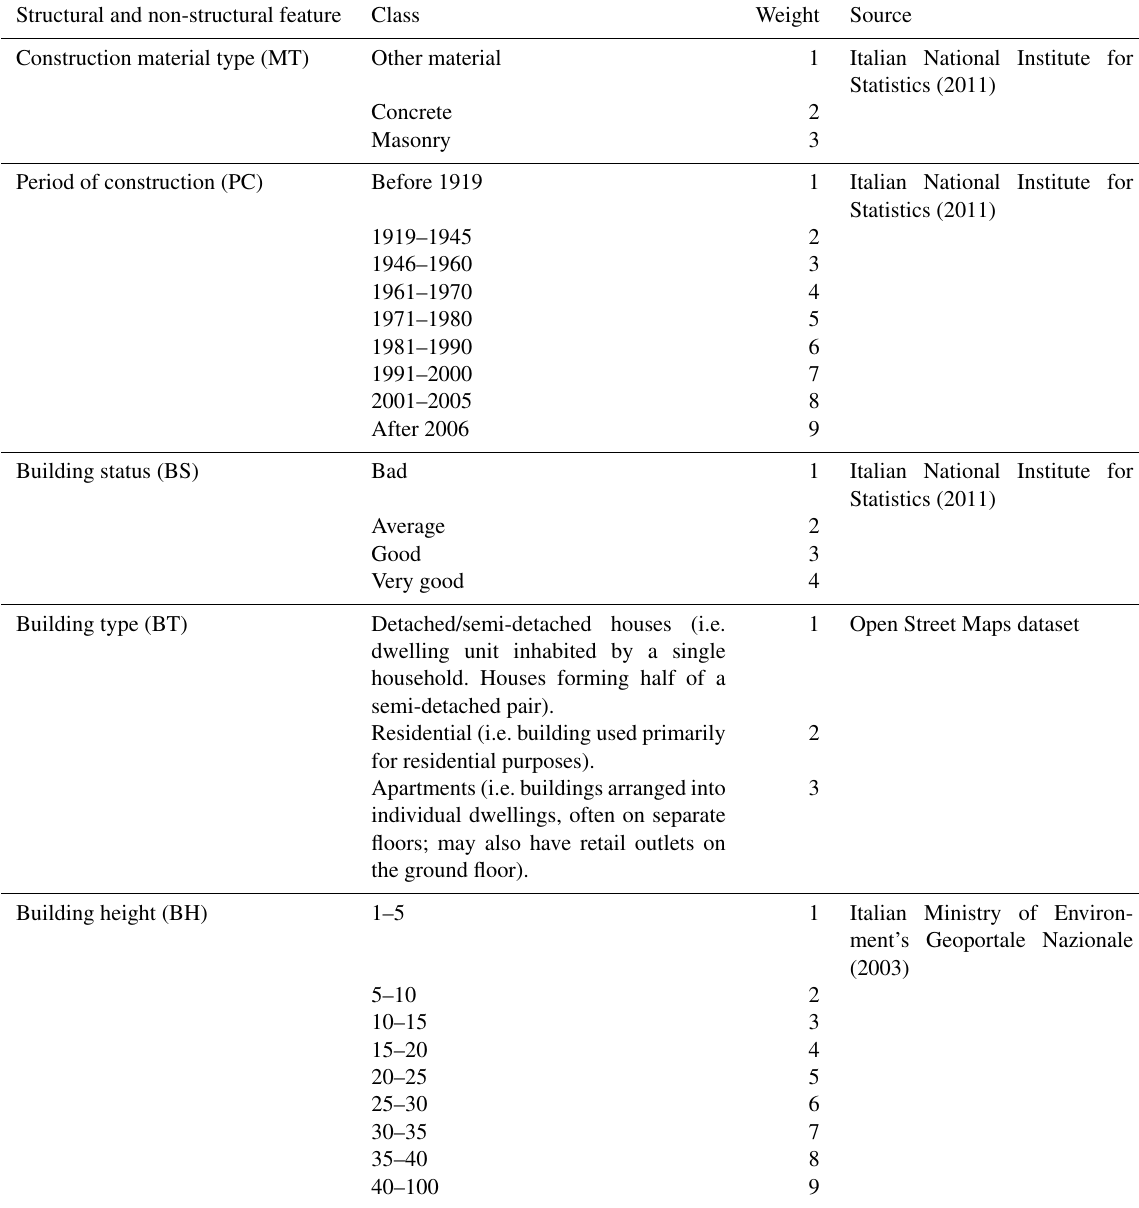
Table 2. Weights assigned to each structural feature composing residential buildings, such as MT (i.e. construction material type), PC